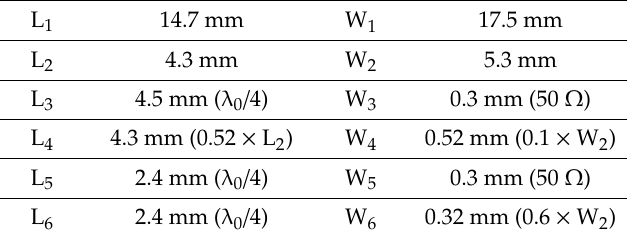
Table 1. Antenna structural parameters.